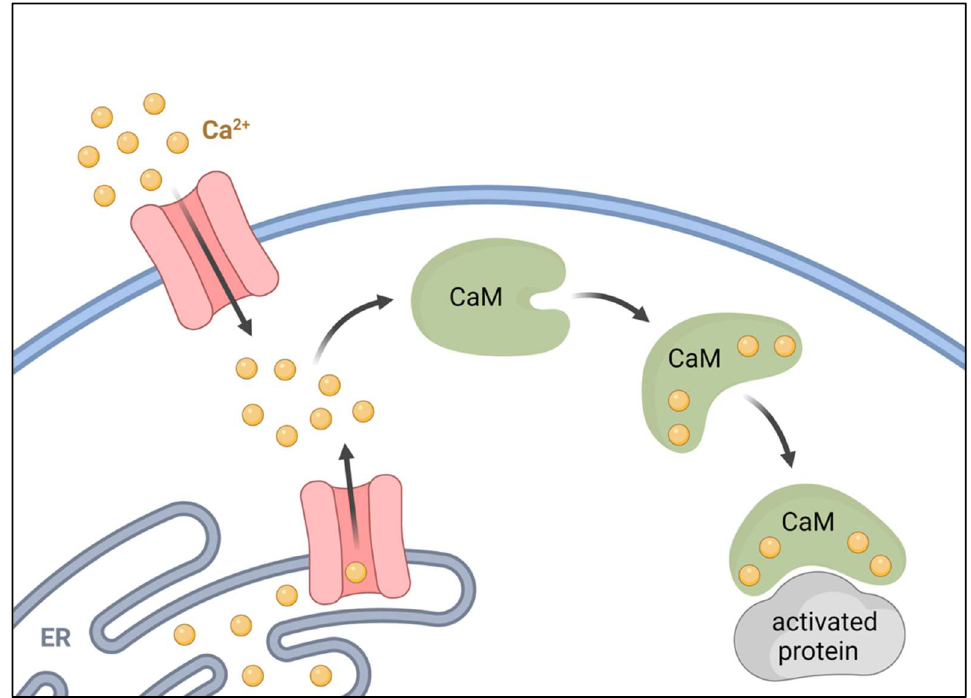
Figure 1. Schematic representation of Ca 2+ -CaM activation. After binding 4 ions of Ca 2+ , calmodulin undergoes conformational change that leads to activation of downstream proteins. The main function of CaM in the heart is modulation of the action potential, leading to rapid contraction of a distinct group of cardiac cells through the regulation of different chan- nels [22,38], such as the voltage-gated sodium channels [50], the voltage gated potassium channels [51], and the voltage-gated calcium channels [52]. CaM is also involved in the regulation of the sarcoplasmic reticulum calcium release channel (RyR2), the main source of intracellular calcium necessary to induce contraction [53,54]. Regulation of RyRs by CaM is isoform specific. For RyR1, CaM exhibits biphasic regulation that depends on Ca 2+ concentration. It acts as a weak activator at nanomolar concentrations of Ca 2+ (apo-CaM) and as an inhibitor at micromolar concentrations of Ca 2+ (Ca 2+ -CaM). On the other hand, for RyR2, Ca 2+ -CaM only inhibits the channel, without activating effects [55]. Moreover, CaM interacts with secondary pathway effectors of cardiomyocyte contraction, such as the beta-adrenergic pathway [56,57] and cyclic nucleotide signalling [38]. In the